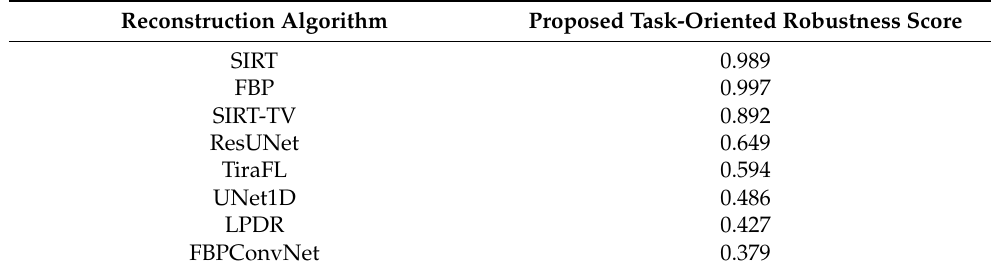
Table 3. Proposed task-oriented score averaged over a set of 4 reconstruction perturbations and over 7 reconstructed